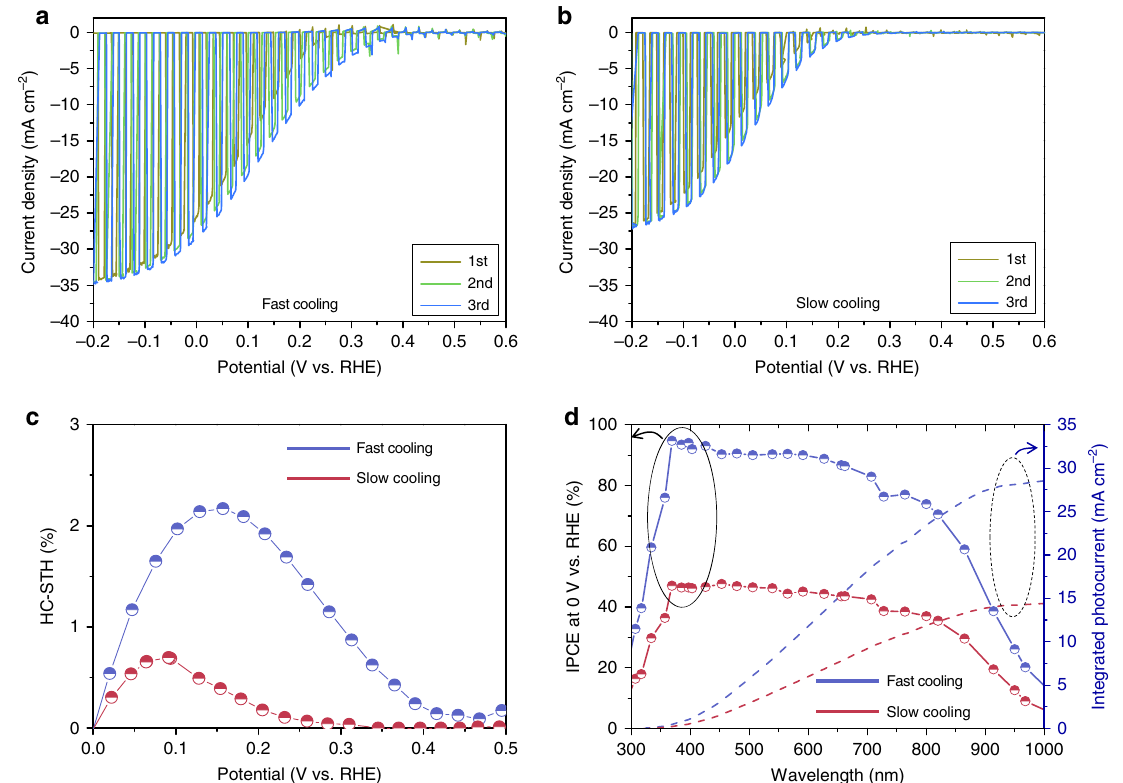
Fig. 2 PEC performance of RuO x /TiO 2 /Sb 2 Se 3 /Au/FTO photocathodes in pH 1 H 2 SO 4 electrolyte. a , b J – V curves of a fast- and b slow-cooling samples under simulated 1 sun air mass 1.5 G chopped illumination at a scan speed of 5 mV s − 1 from positive to negative potential and c corresponding HC-STH ef fi ciencies. d Wavelength-dependent IPCE and integrated photocurrent density of fast- and slow-cooling samples measured at 0 V RHE . Source data used to generate this fi gure can be found in the Source Data fi